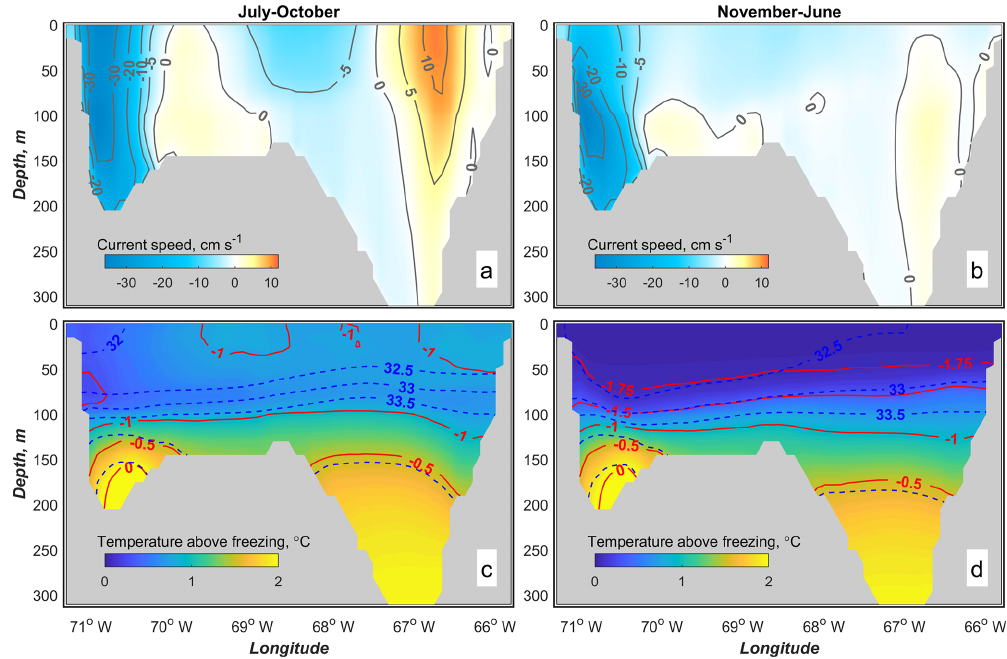
Figure 9. The modeled mean 2006–2010 summer (mobile ice) and winter (ice bridge) cross-sectional current speed (a, b) and water temper- atures and salinities (c, d) at the transect across the central Kane Basin. Positive speeds correspond to northward